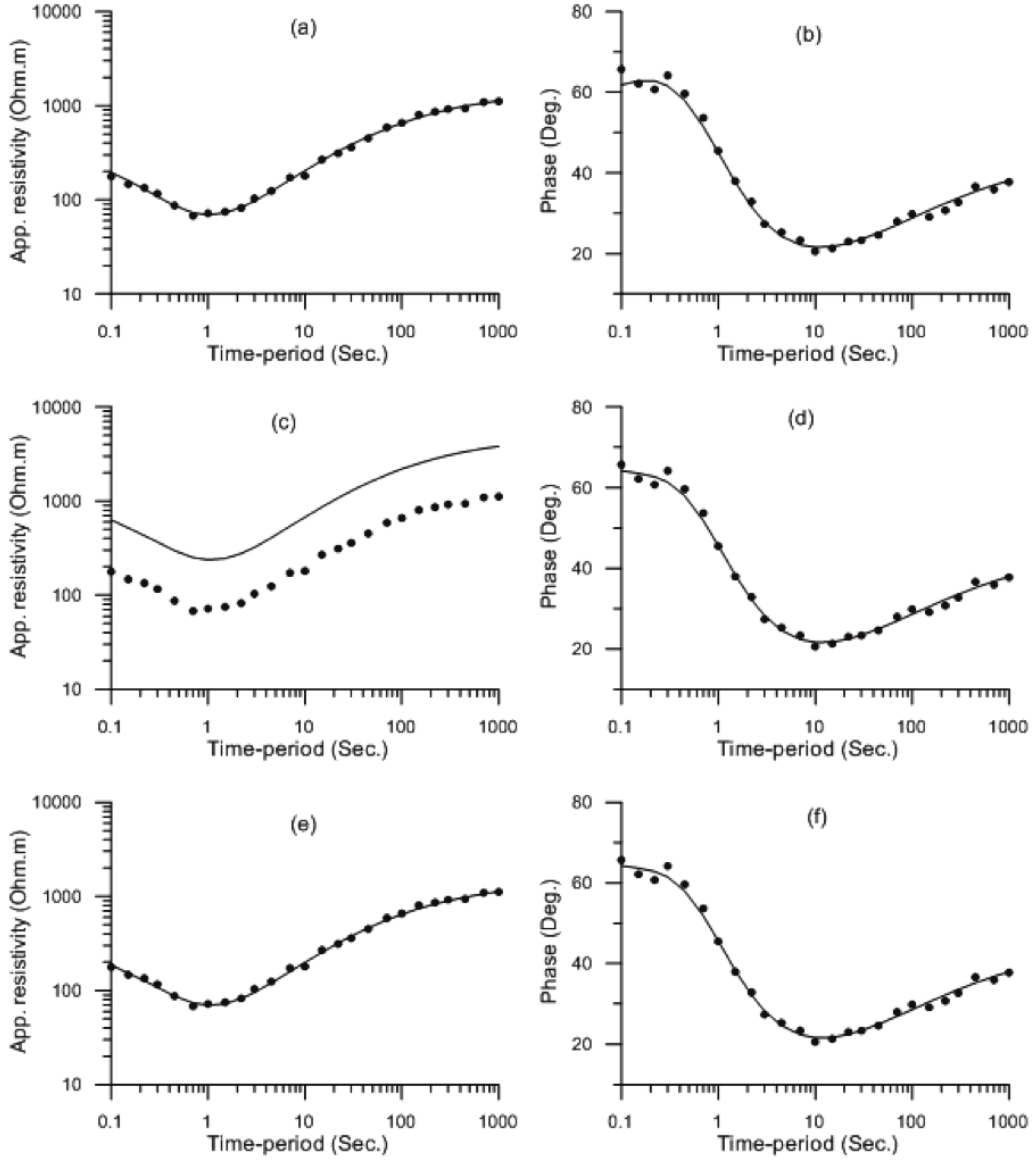
Figure 5. Comparisons between observed data (solid symbols) and model data (lines) for model 4 after inversion of the apparent resistivity data (a, b), the phase data (c, d) and both sets of data (e, f).